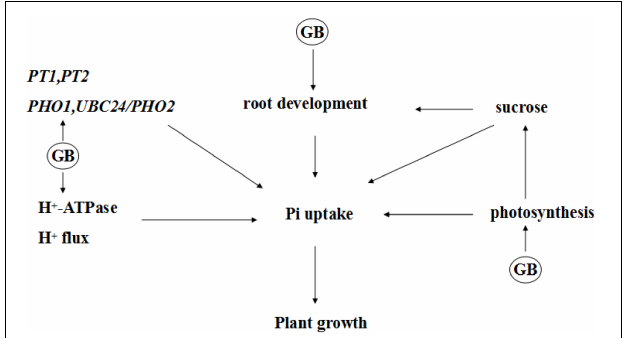
FIGURE 9 | A possible model to show the probable mechanism of how GB regulates phosphate acquisition in transgenic tomato plants under low phosphate